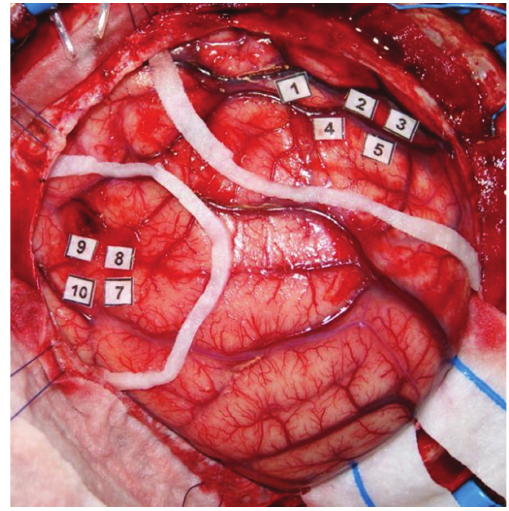
Figure 3: Intraoperative photo showing areas of language- associated activation (stickers 7–10) and right-hand motor activa- tion (stickers 1–5). Note that eloquent areas with 1cm safety margin have been outlined by a white cottonoid strap.